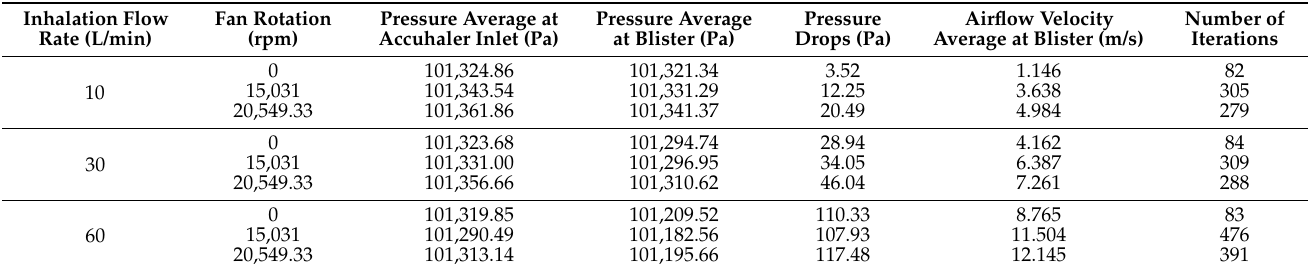
Table 5. Pressure profile and Airflow velocity at the blister pocket in Accuhaler with or without add-on device as determined through CFD